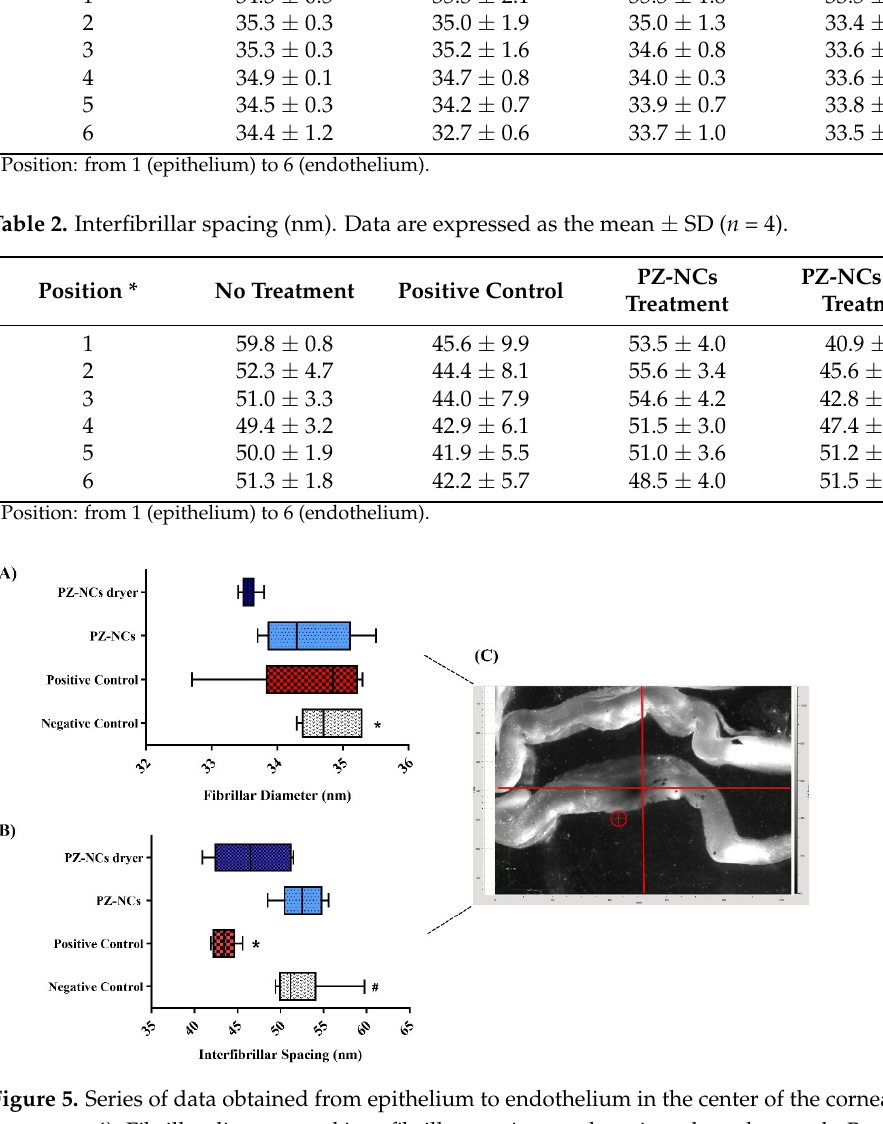
Table 1. Fibrillar diameter (nm). Data are expressed as the mean ± SD ( n = 4). Position * No Treatment Positive Control